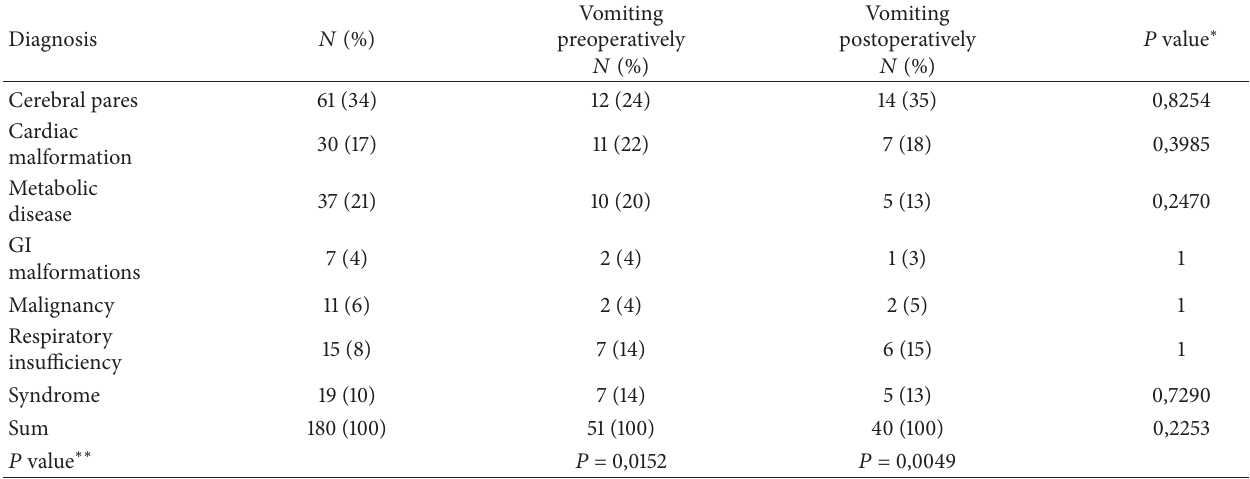
Table 2: The diagnosis of the included 180 patients and their vomiting frequency pre- and postoperatively at study endpoint at 6 months. The children had comorbidity in the form of epilepsy in 27 (17%), ventricular-peritoneal shunt in 9 patients (5%), and mitochondrial disease in 6 patients